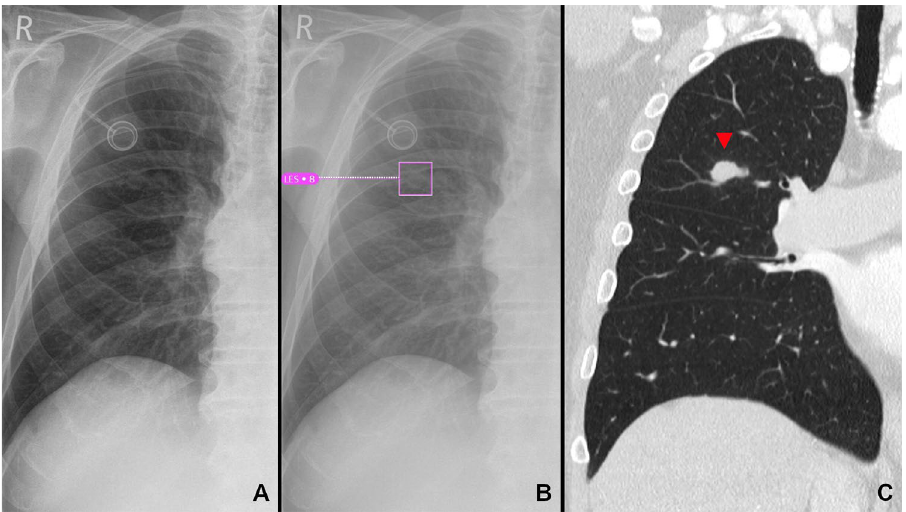
Figure 2. Example of a lung lesion detected by the AI Rad Companion Chest X-ray ( A , B ) that was confirmed by a CT scan of the chest ( C ): 74 year old, male patient diagnosed with a carcinoma of the tongue 2 years ago.